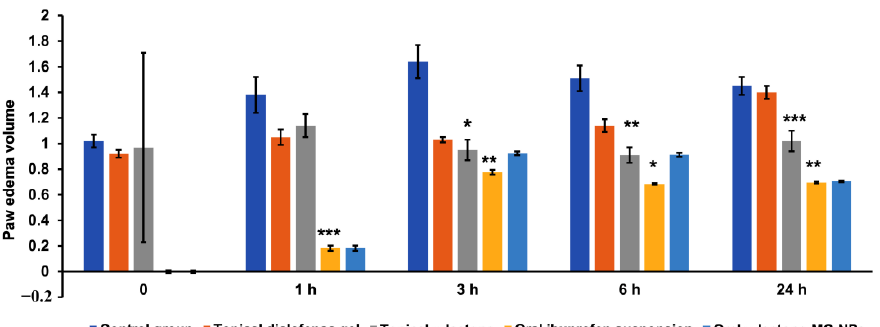
Figure 4. The percent of edema inhibition in cu.mm in the control group, topical diclofenac gel treated group, oral ibuprofen treated group, topical γ -lactone treated groups, and γ -lactone-MC-NPs treated group. Diclofenac gel and γ -lactone were administered at 300 mg diclofenac of 1% w / w and 30 mg γ -lactone. Ibuprofen suspension administered at 30 mg/kg, γ -lactone-MC-NPs was administrated at 10 mL/kg of γ -lactone (each 1 mL contains 223.5 µ g). The results are expressed by Mean ± SEM ( n = 30). One-way ANOVA followed by Tukey–Kramer multiple comparison test showed * p < 0.05 ** p < 0.01 and *** p < 0.00 as compared to the positive control group and the reference group. After 24 h the diclofenac gel effect was nearly to be abolished as the mean paw volume was 1.40 ± 0.05 cu.mm approaching that of the positive control (1.45 ± 0.07 cu.mm), in contrast γ -lactone continued to show the anti-inflammatory effect even after 24 h as the mean paw volume was 1.02 ± 0.08 cu.mm ( p- value < 0.001). These results confirmed